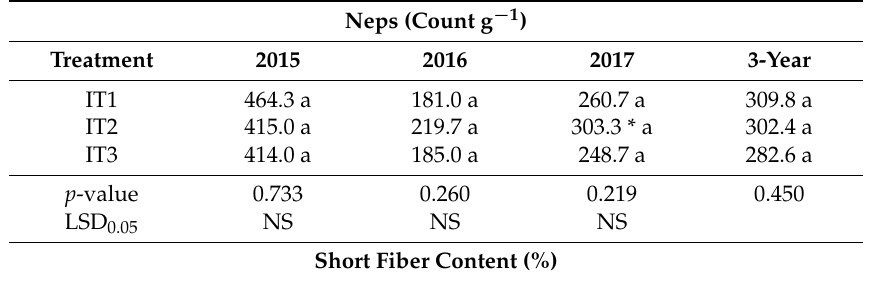
Table 7. Cotton advanced fiber information system (AFIS) properties. Within each year, means followed by the same letter are not significantly different at the 0.05 level according to the